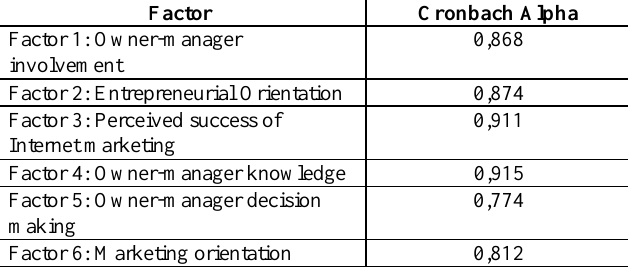
Table 2: Cronbach alpha coefficients Table 3: Multiple regression results: determinants of successful internet